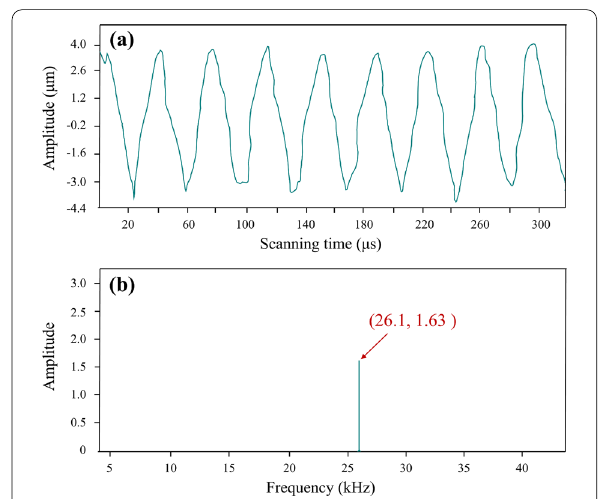
Figure 5 Ultrasonic vibration signal of the end milling process: a ultrasonic vibration signal of the end mill in time-domain, b the corresponding spectrum of ultrasonic vibration signal processed by